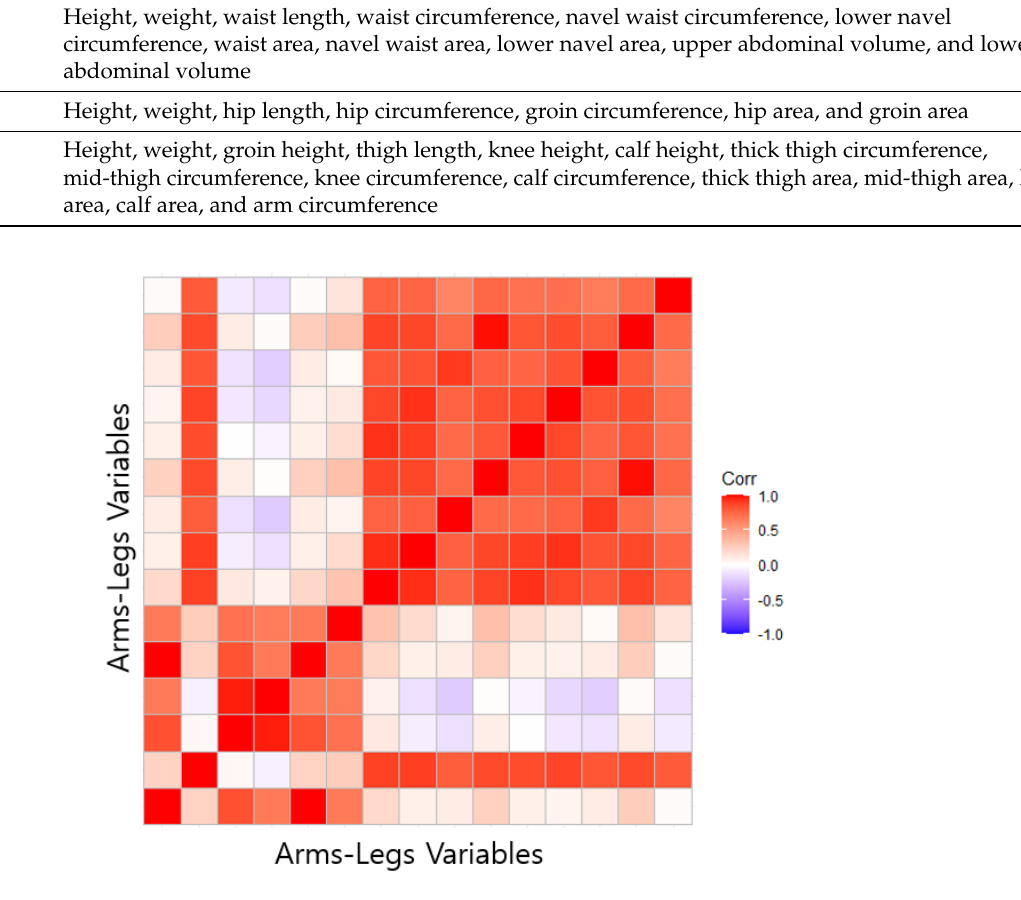
Figure 3. Arms-legs correlation.